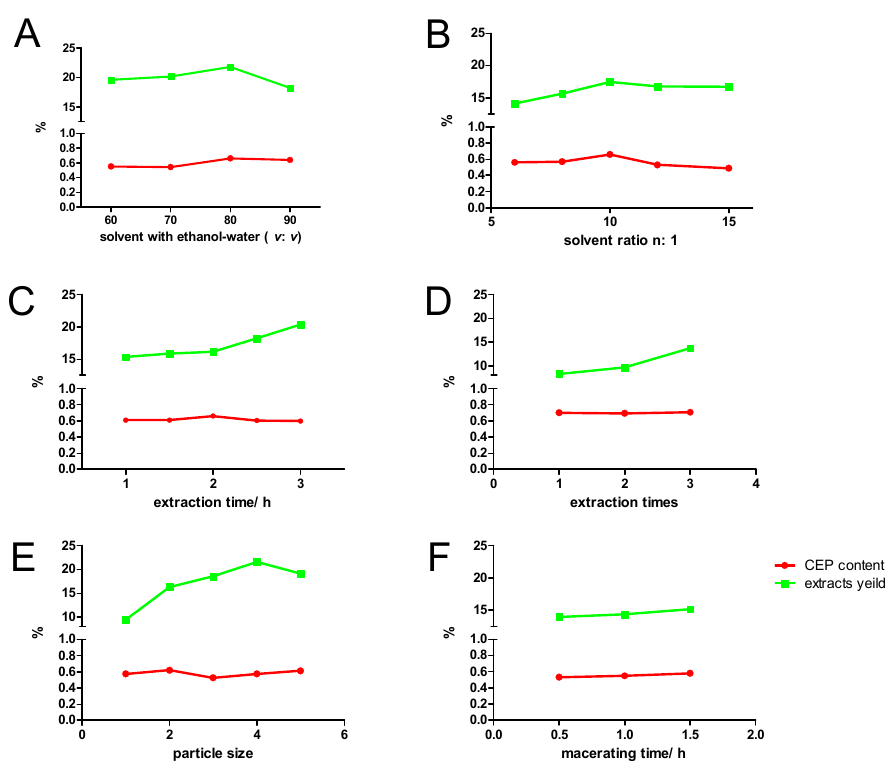
Figure 1. Optimization of the extraction process of crude extractions: ( A ) solvent: 60%, 70%, 80%, and 90% ethanol-water ( v / v ); ( B ) liquid to raw material ratio (6:1, 8:1, 10:1, 12:1, and 15:1), ( C ) extraction duration in hours, ( D ) extraction times, ( E ) particle size: 1 for decoction pieces, 2 for coarse powder, 3 for 7 g of powder, 4 for 40 g of the powder, and 5 for 100 g of the powder; and ( F ) macerating time in hours. Green: the weight of extractions (%), Red: the content of CEP in extracts (%).